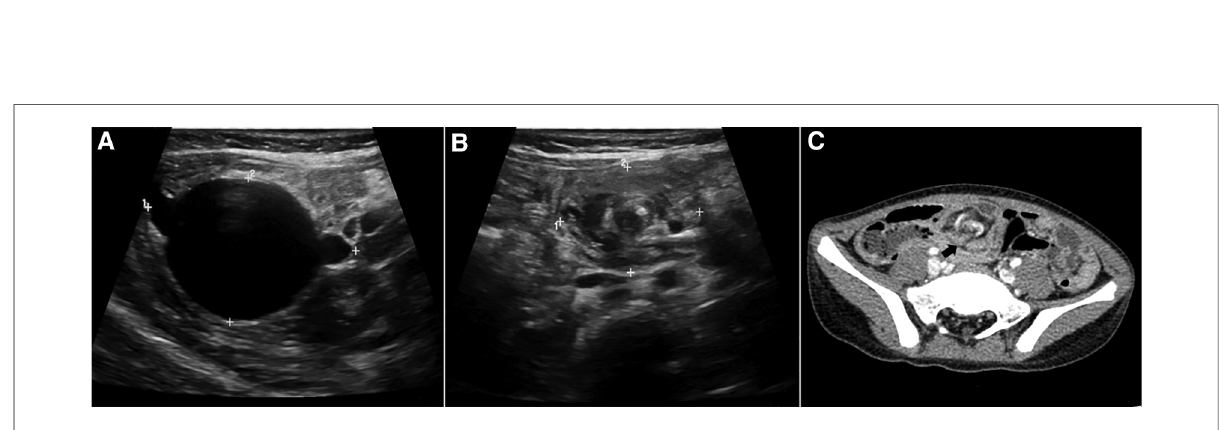
FIGURE 3 Imaging of MCs complicated with volvulus. ( A ) Sonographic imaging demonstrating a well-marginated cyst; ( B ) proximal mesentery with the alternating rings (asterisk) of low and high echogenicity due to volvulus (concentric circle sign); ( C ) enhanced CT scan revealing the whirlpool sign (asterisk) of the mesenteric artery and vein